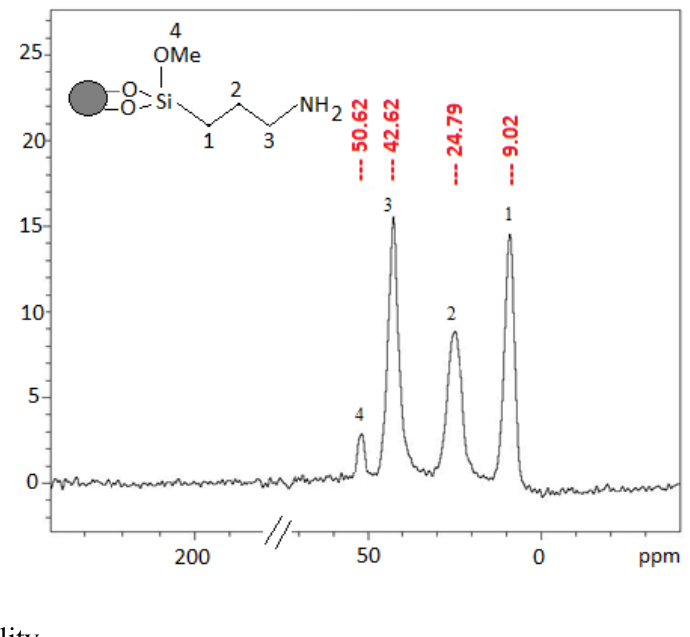
Figure 4. 13 C-NMR spectra of 3-aminopropylsilica (SiNH